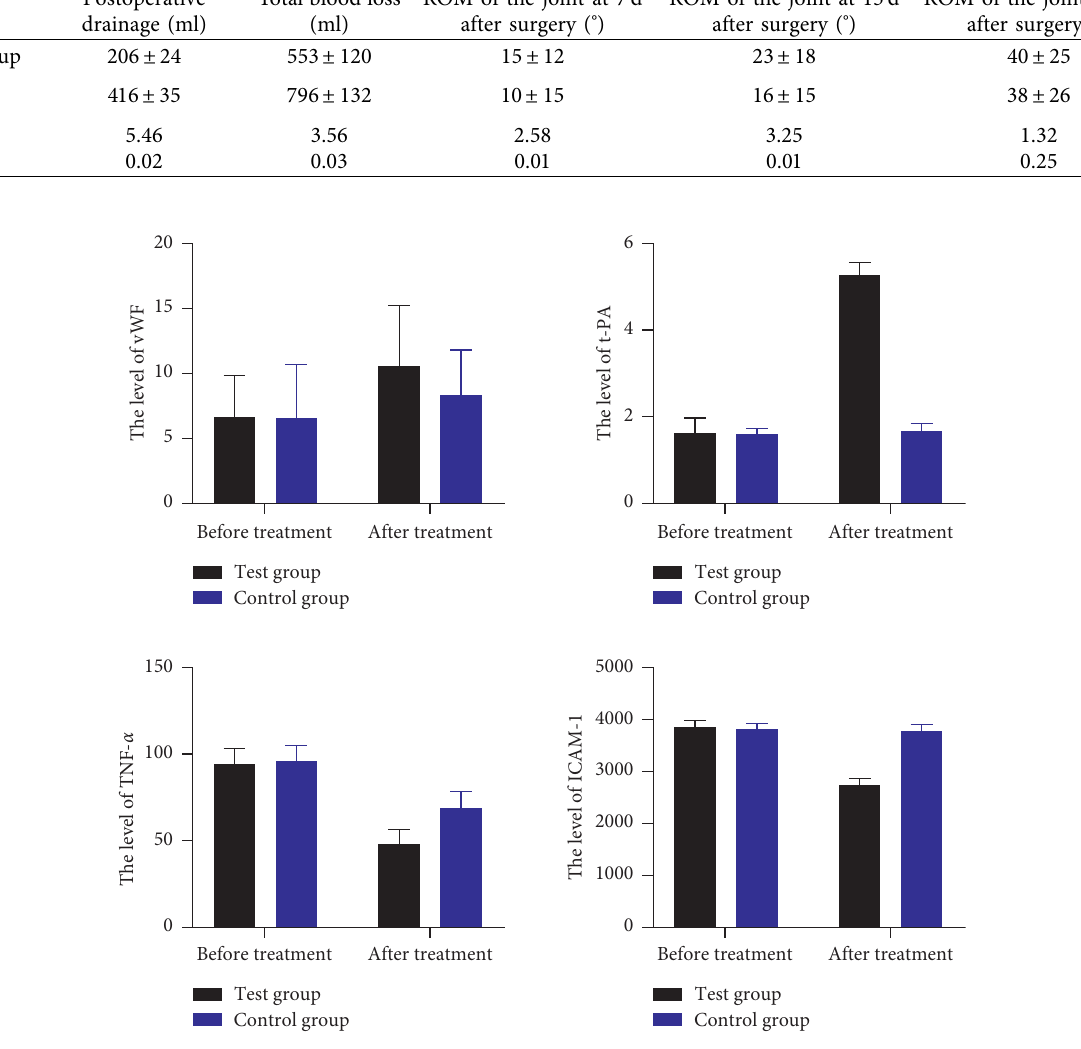
Figure 1: The serum levels of VWF, t-PA, TNF- α , and ICAM-1 between the test group and the control group before and after